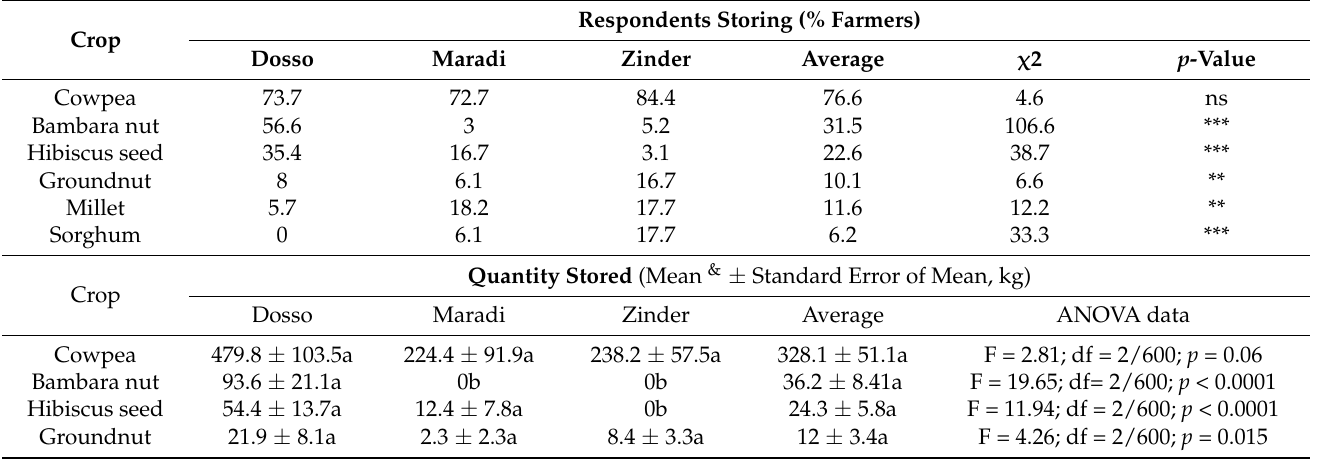
Table 5. Proportion of farmers who stored different crops and quantities stored using PICS Bags in Dosso, Maradi, and Zinder regions of Niger. Crop